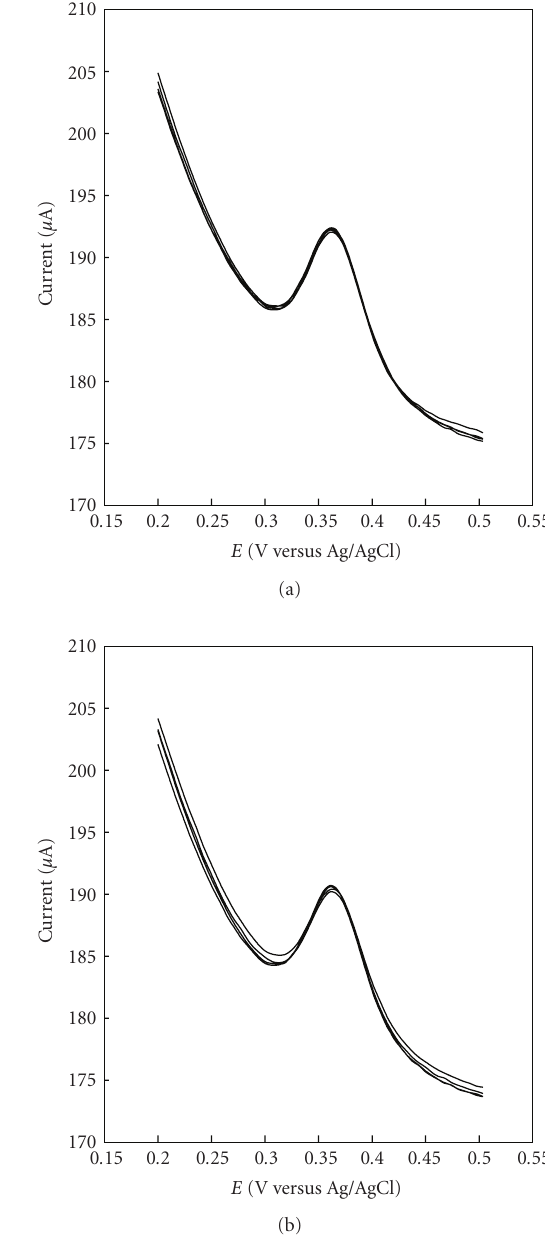
Figure 9: Four repetitive DPVs of 0.5 μ M AC on the surface of oppy/MWCNT/GCE during (a) one day and (b) four days. Potential sweep rate was 100 mVs − 1 and supporting electrolyte was 0.1 M phosphate bu ff er solution of pH